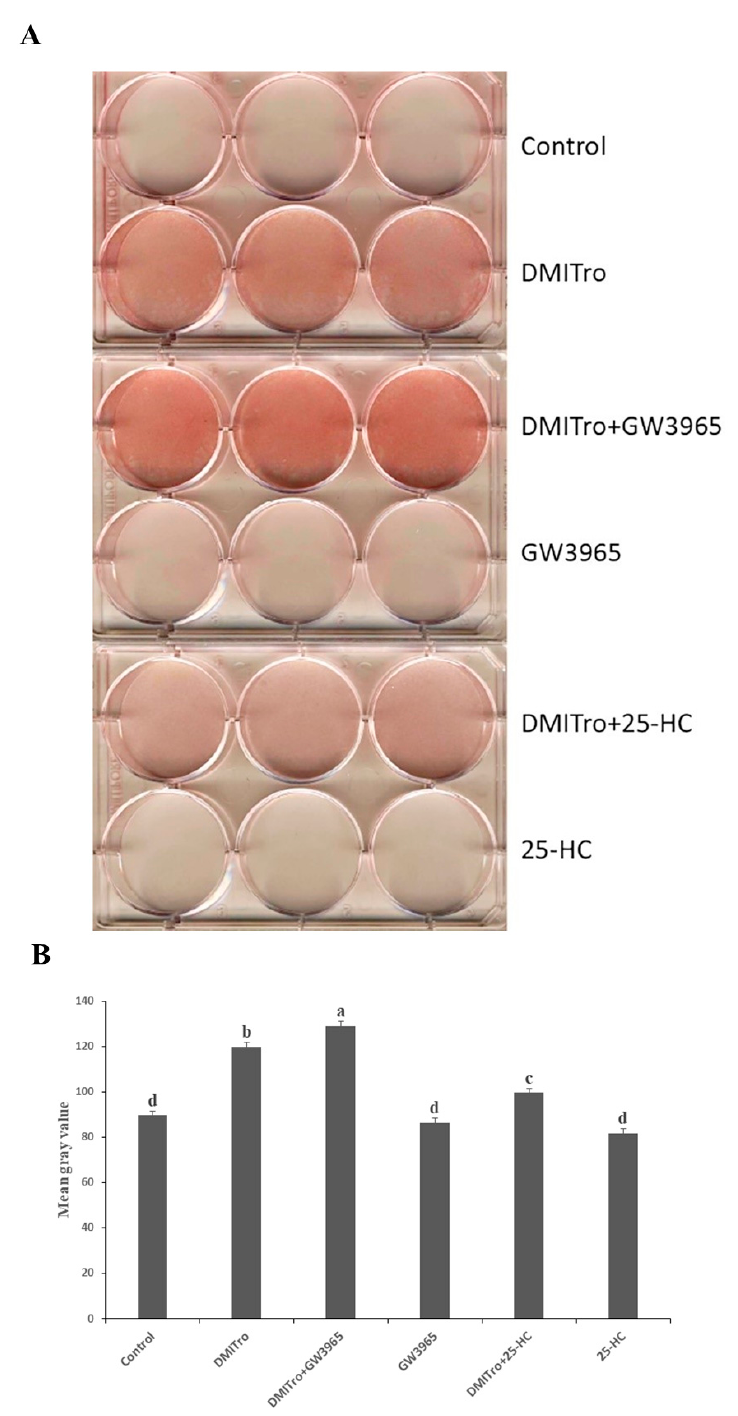
Figure 9. Liver X receptor agonist, GW3965, enhances lipid accumulation in cells treated with the adipogenic media, DMITro. C3H10T1/2 cells at confluence were treated with a control, 2 µM GW3965 or 10 µM 25-HC, with or without DMITro for 96 h, followed by Oil red staining to assess the extent of lipid accumulation in the treatments. ( A ) oil red O stanning results ( B ) The mean gray value (in pixel) of oil red O staining. The results show the average values of three replicates ( n = 3) and the SE of the means. Bars with the different letters are significantly different ( p < 0.001).